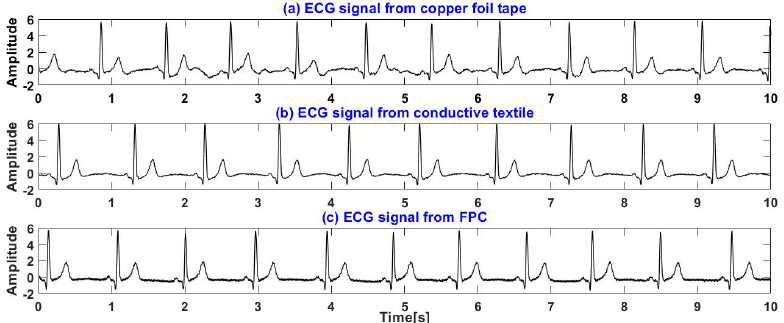
Figure 15. ECG signals of a subject lying supine on a recliner: ( a ) ECG signals measured by copper foil tape. ( b ) ECG signals measured by conductive textile. ( c ) ECG signals measured by